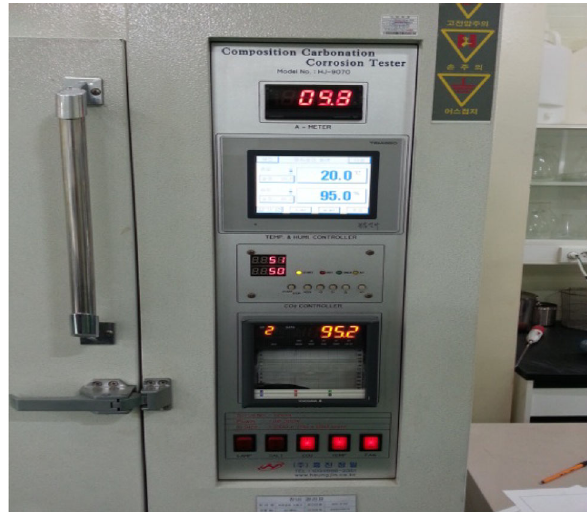
Fig. 1 Concrete carbonation chamber.